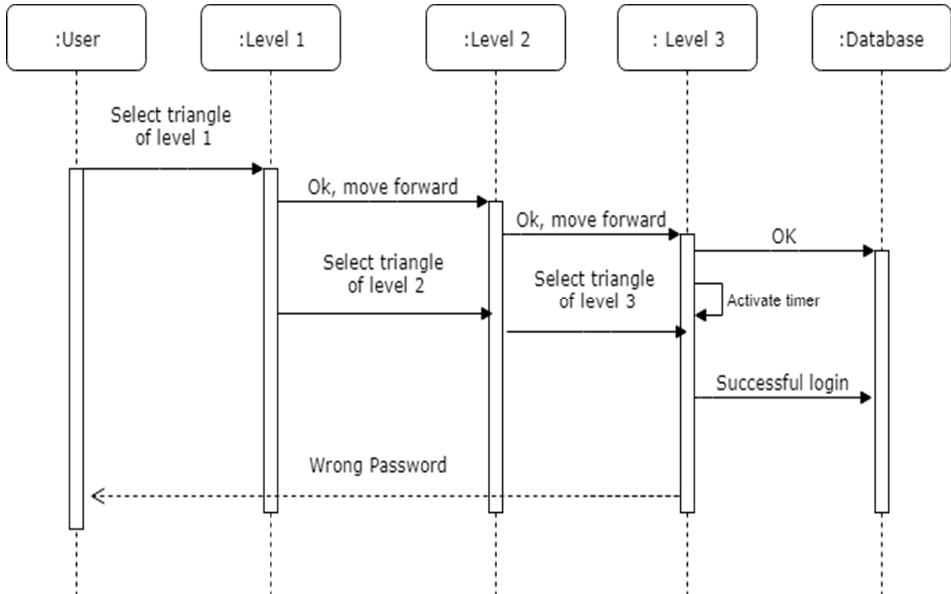
Figure 5. Sequence diagram for password authentication.